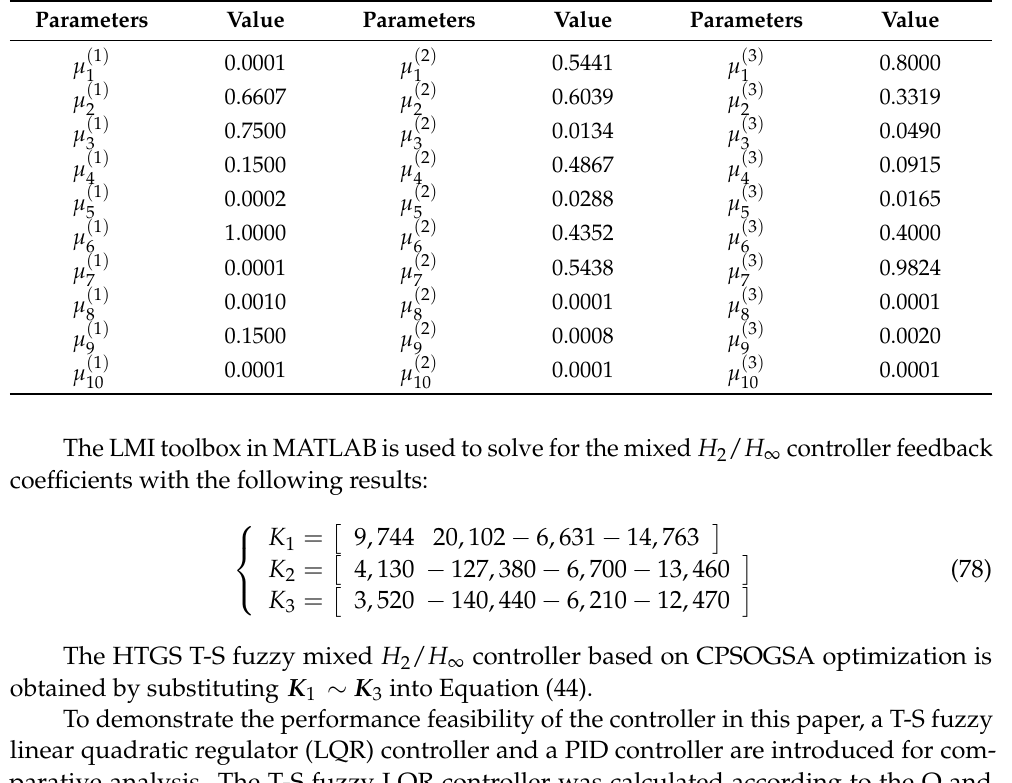
Table 3. Weighting